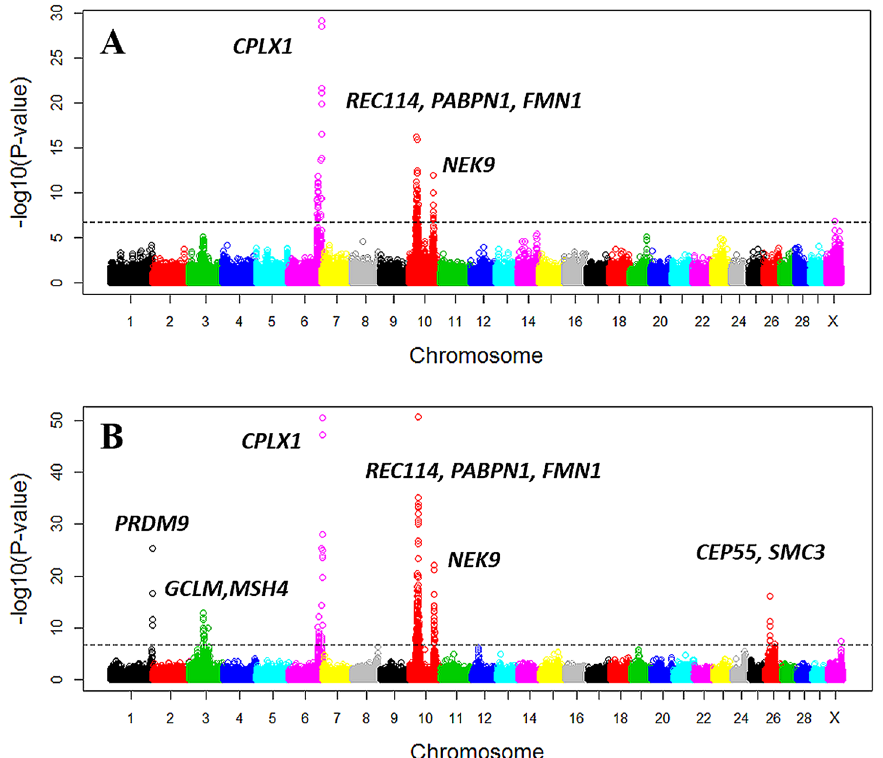
Fig 5. Manhattan plot of the GWAS of genome-wide recombination rates for males (A) and females (B). Different colors were used to distinguish the 29 chromosomes. The genome-wide significance level of 1.6×10 − 7 was shown by the horizontal dotted line. USDA-AGIL SNP coordinates were used for plotting, which placed PRDM9 -linked SNPs to the end of Chromosome 1. Note that UMD3.1 assembly placed PRDM9 near the middle of Chromosome